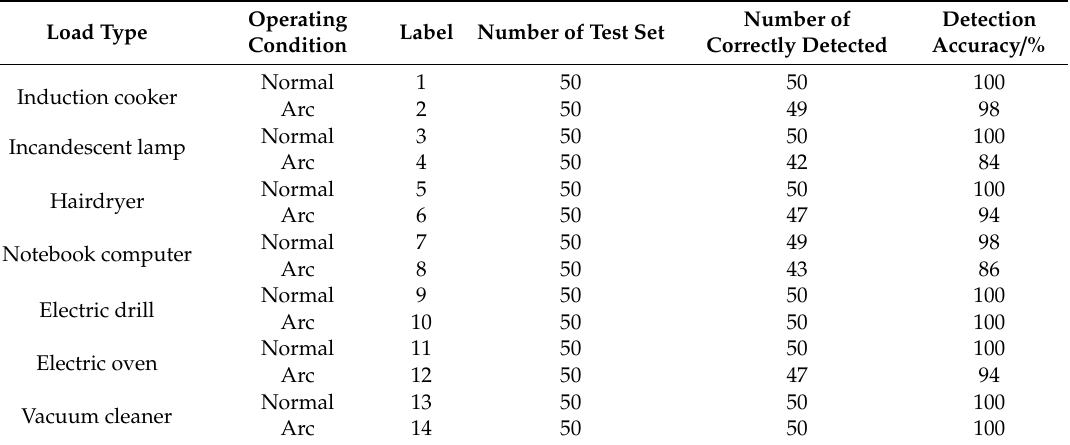
Table 4. The detection results of the random forest (RF).